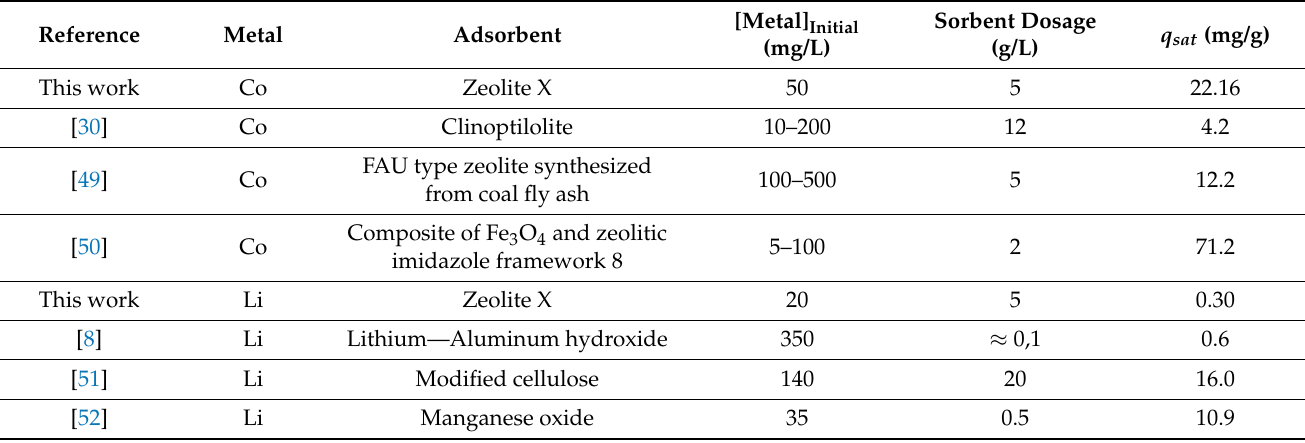
Table 7. Comparison between literature and the most significative results obtained in the current